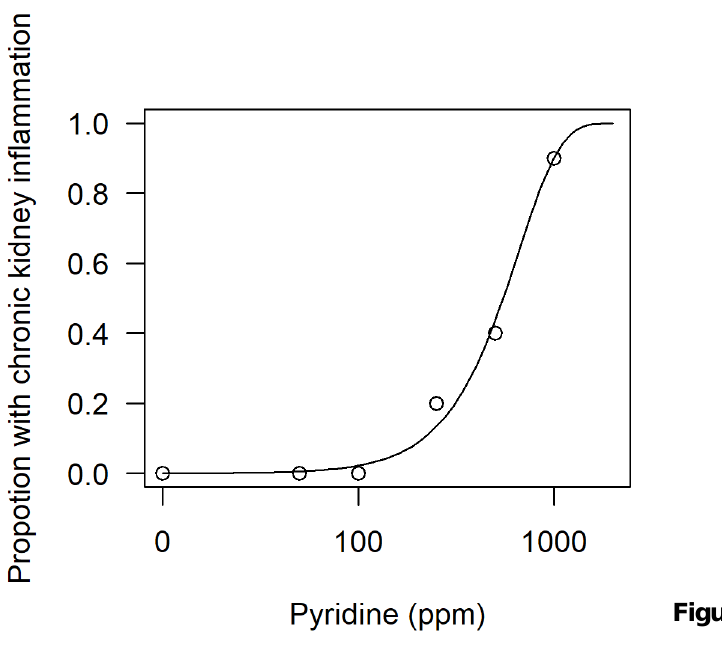
Figure 4: Default plot of the drc